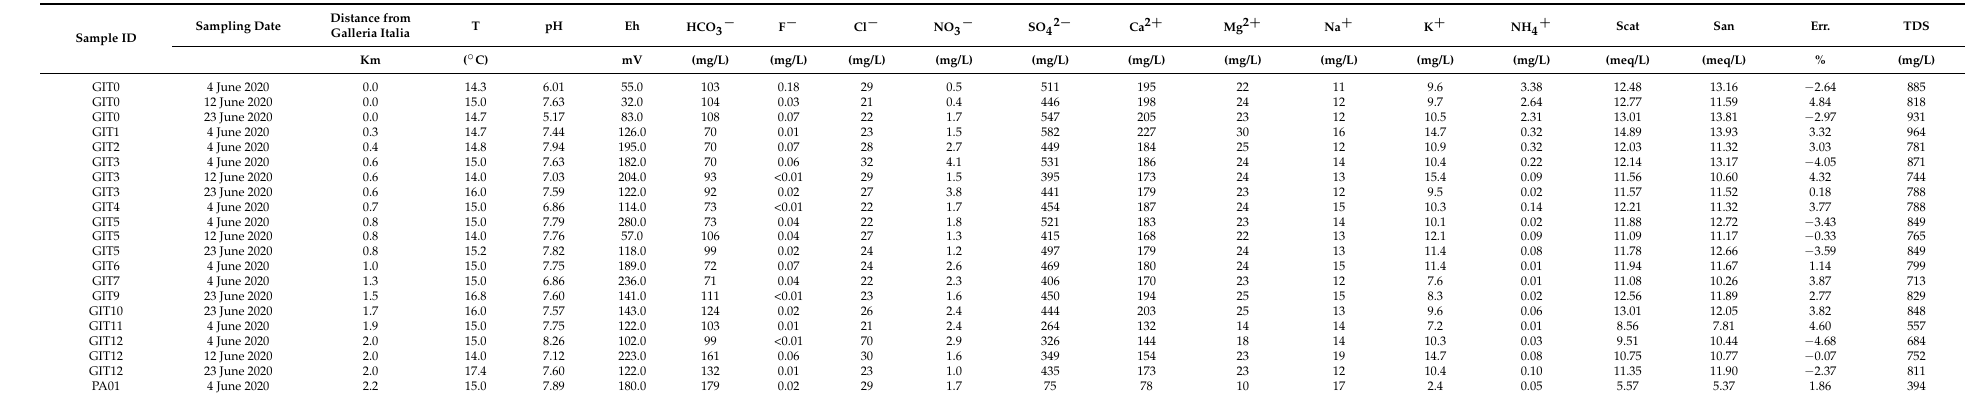
Table 1. Physicochemical data and concentrations of main and minor anions, cations, and TDS (in mg/L), measured along the Fosso della Chiusa creek and in the Pagliola creek before the confluence of the FdC creek. Scat and San are in meq/L, while Err. (in %) is expressed as ((Scat − San)/(Scat + San)) ∗